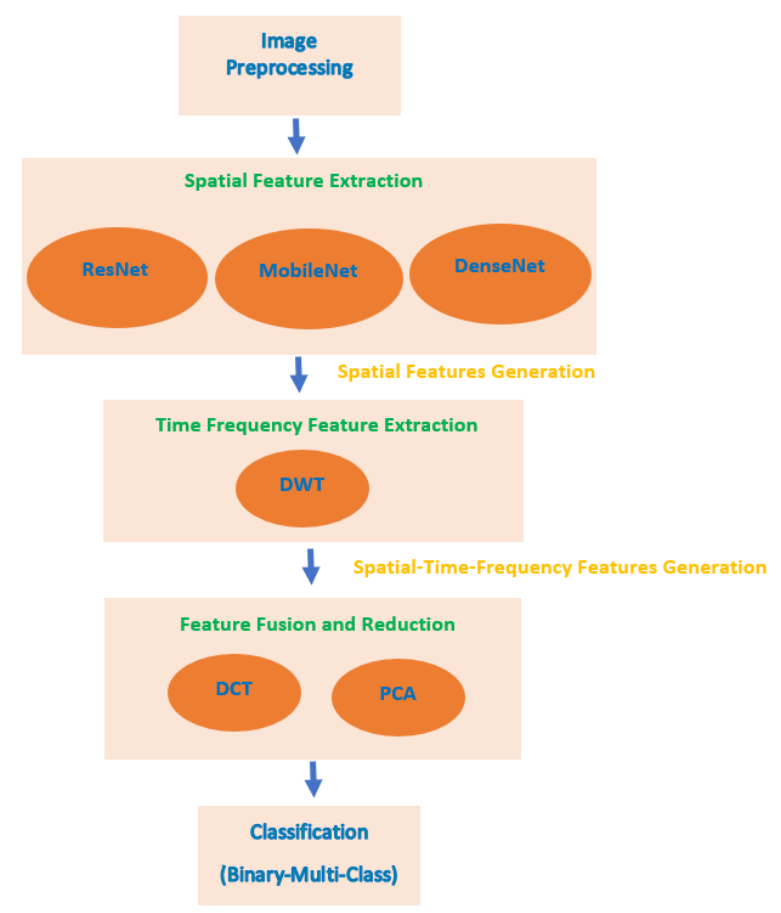
Figure 5. A block diagram of the proposed